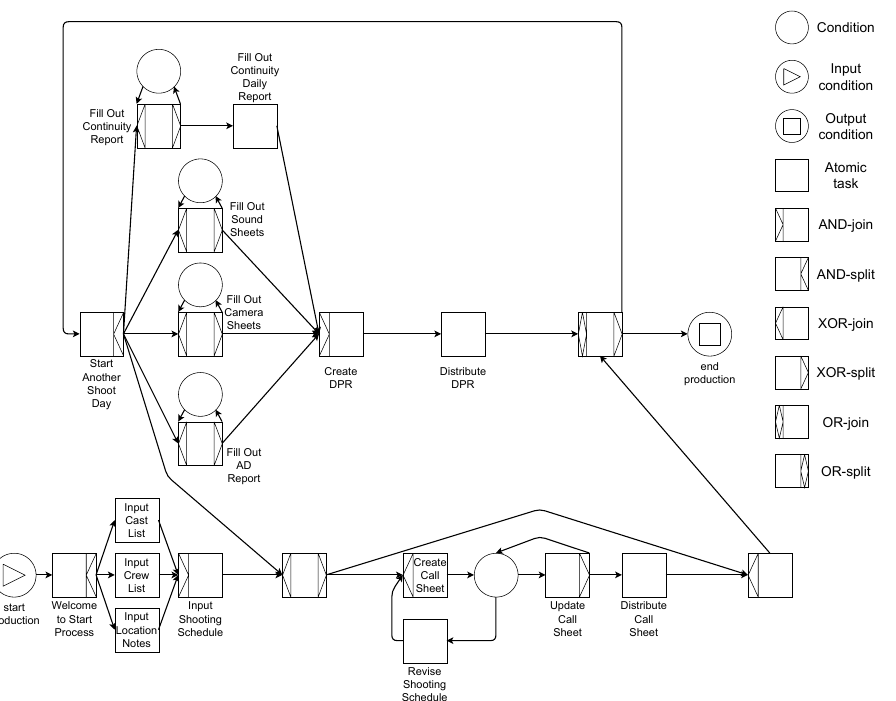
Figure 10. Film production process represented in YAWL. This case study represents the chain of information processing realized along the shooting of the movie. Although the shooting is taking place during the day, a designated crew collects the information associated with the shooting via production forms, which are used to produce the daily progress report. A call sheet containing all the information concerning logistics and necessities is also